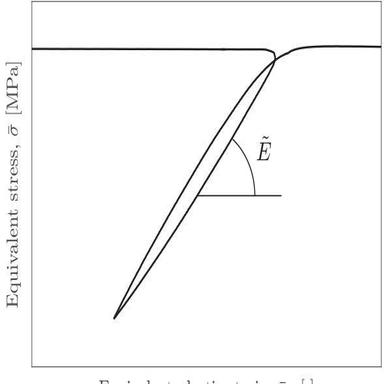
Equivalent stress - equivalent plastic strain (σ¯ - ε¯pl) of one unloadingreloading cycle.